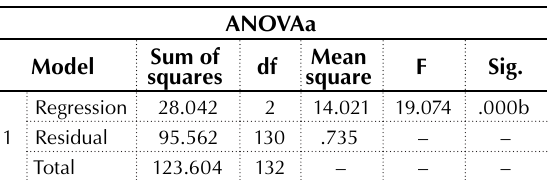
Table 9. Correlation analysis between social